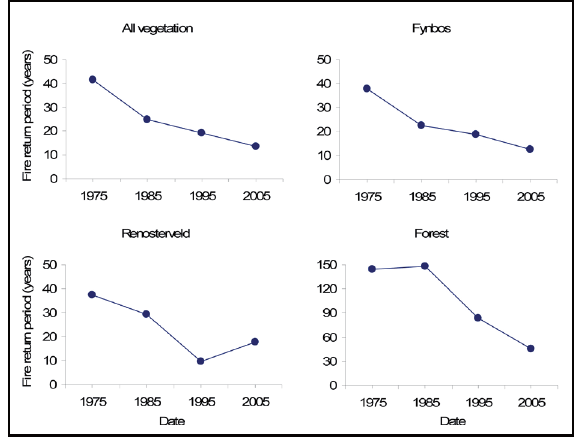
Figure 1 Mean fire return periods per decade in the Table Mountain National Park and in three component vegetation types. Note the difference in scale for forest